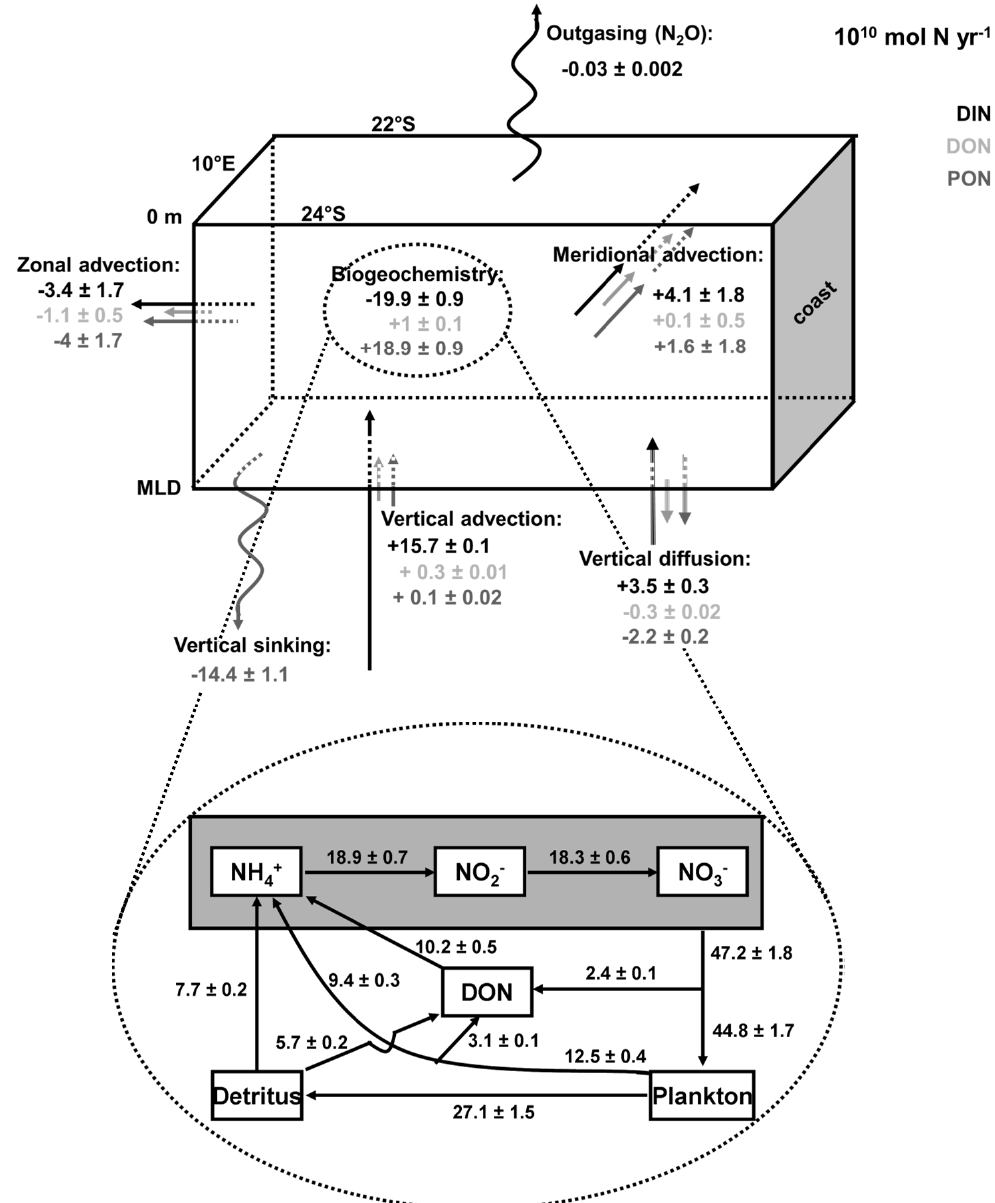
Fig. 4. Full nitrogen budget in the mixed layer (10 10 molNyr − 1 ) with zoom on biogeochemical fluxes. Fluxes of DIN are indicated in black, DON are in light grey and PON in dark grey. As NO − assume them equal to DIN fluxes. Fluxes are 8yr means, averaged between 22 ◦ S and 24 ◦